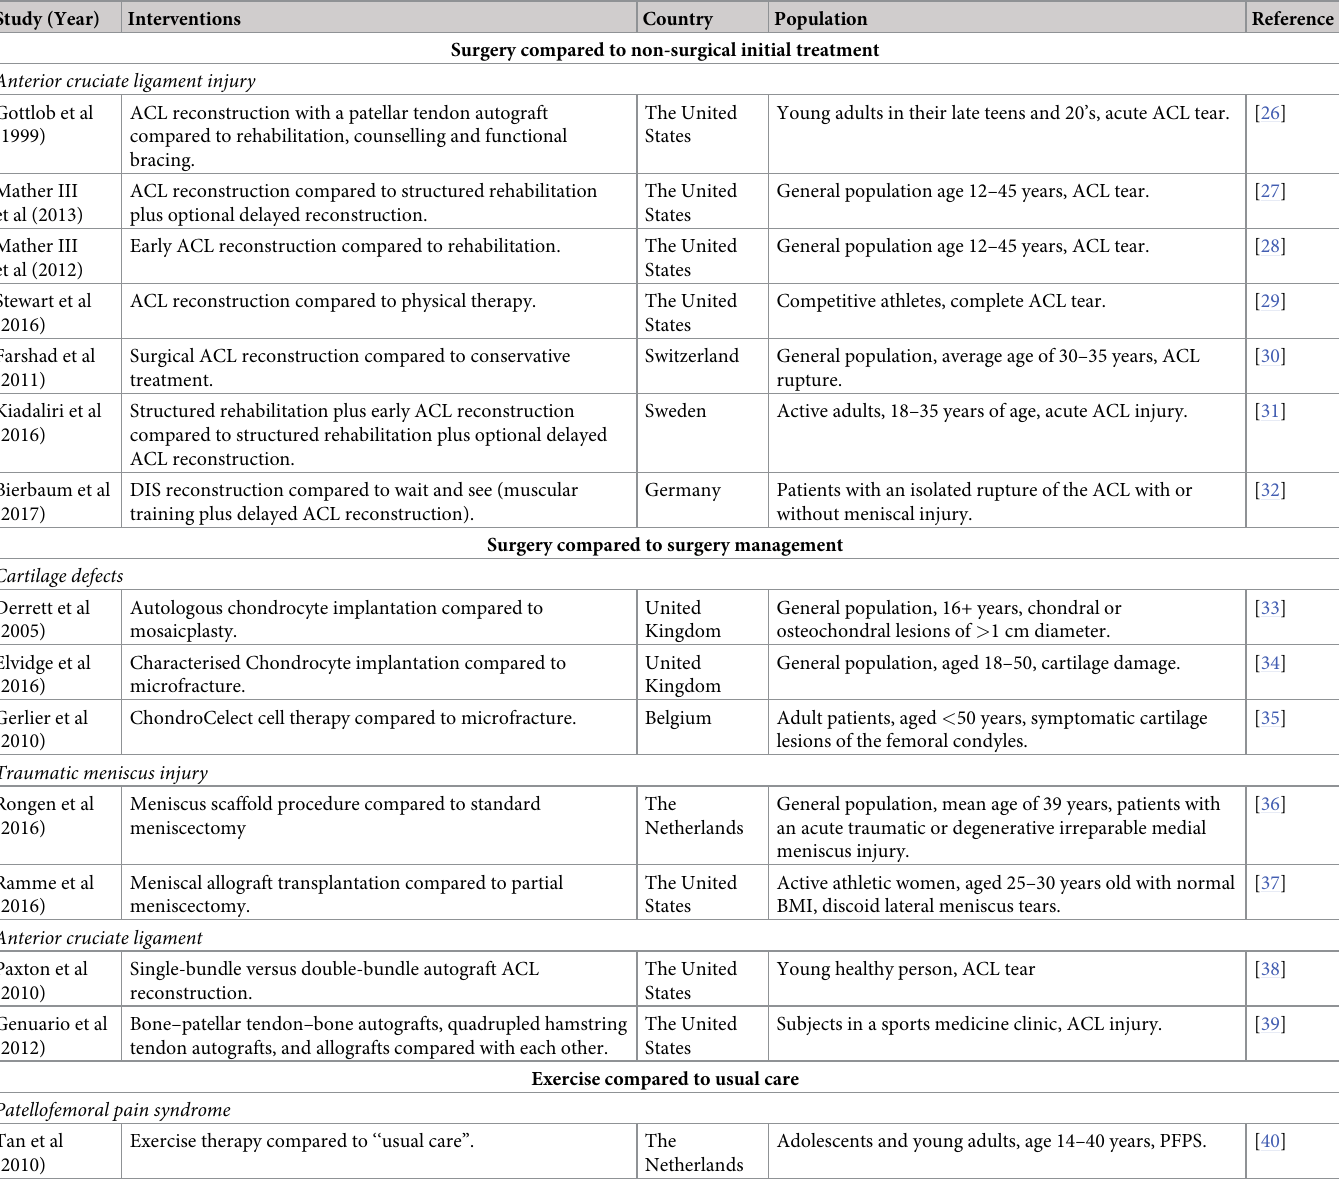
Table 2. Overview of the identified